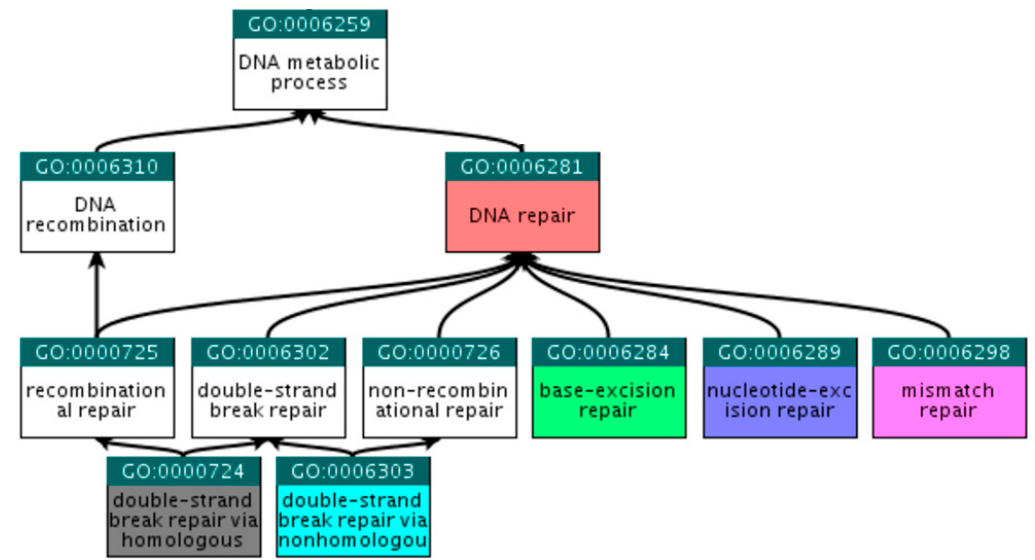
Figure 4. Ancestor tree showing the hierarchical relations of the six selected GO terms.